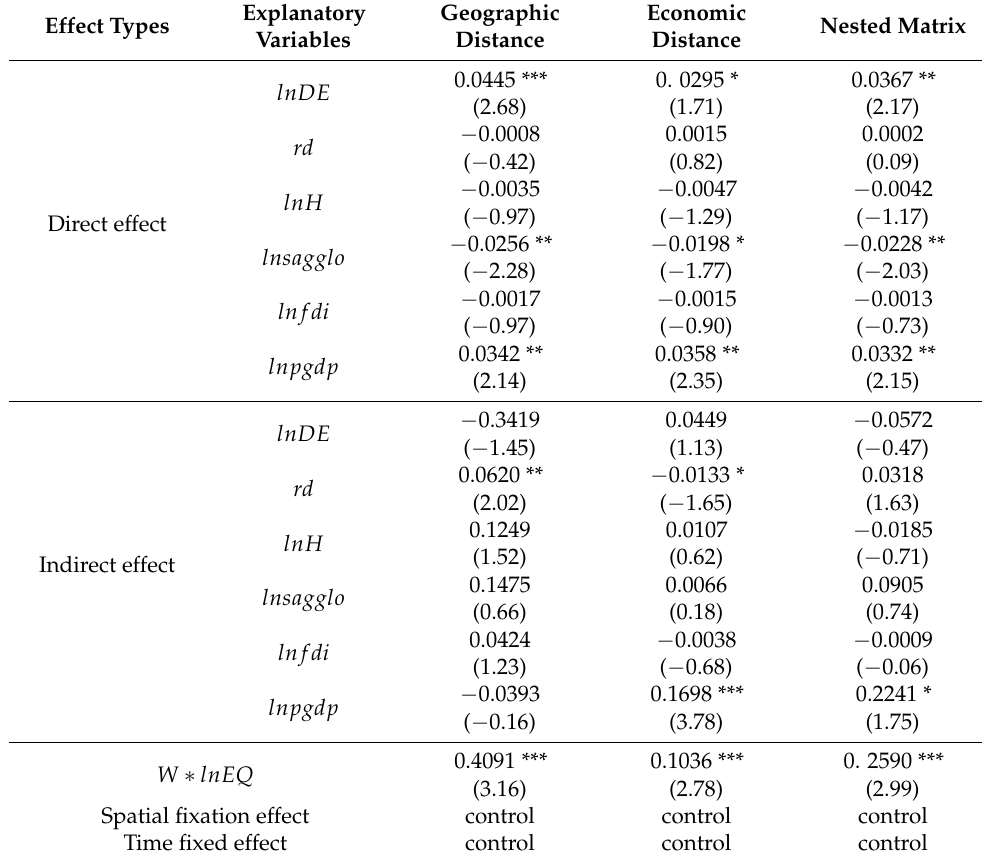
Table 9. Direct and indirect effects of the digital economy on urban environmental